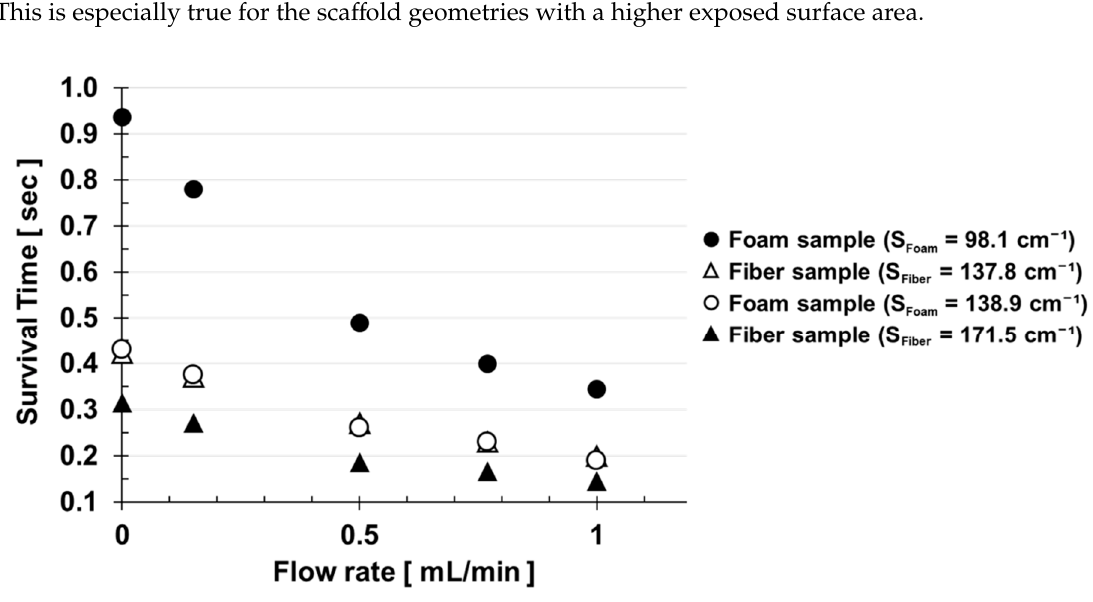
Figure 5. Survival time in the stream-wise direction as a function of perfusion flow rate and scaffold architecture. Data is plotted for the limiting case of the fully reactive rLST particles.